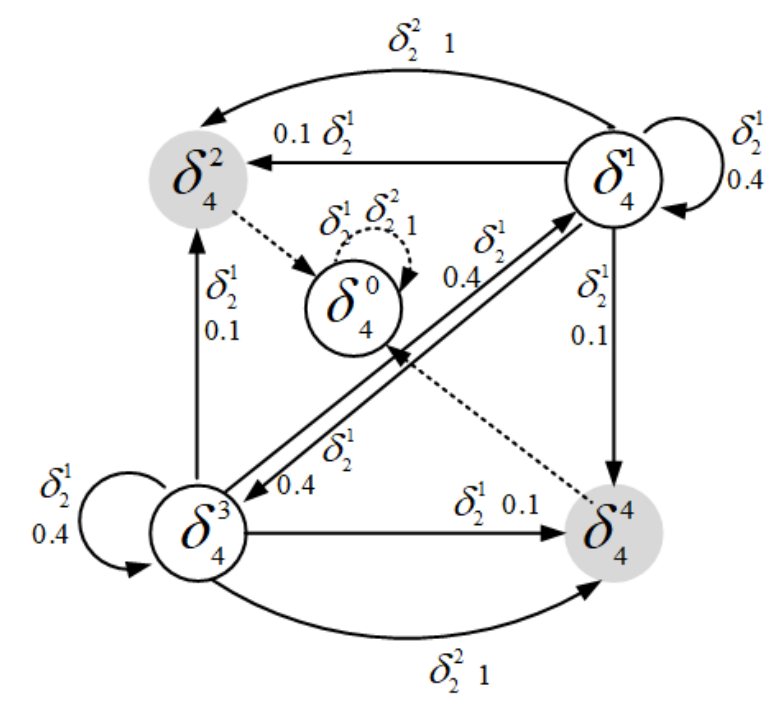
Figure 2. STG of the RLDS (7) in Example